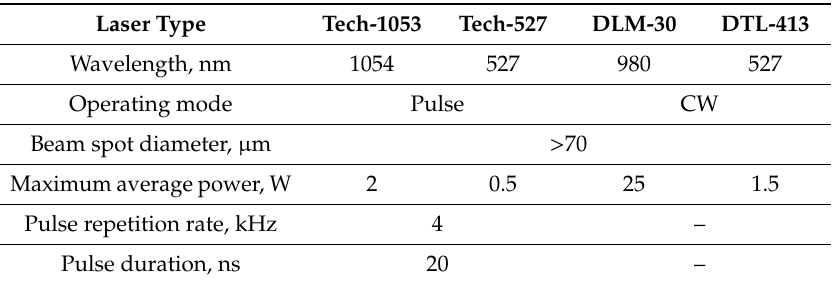
Table 1. Lasers operating parameters.